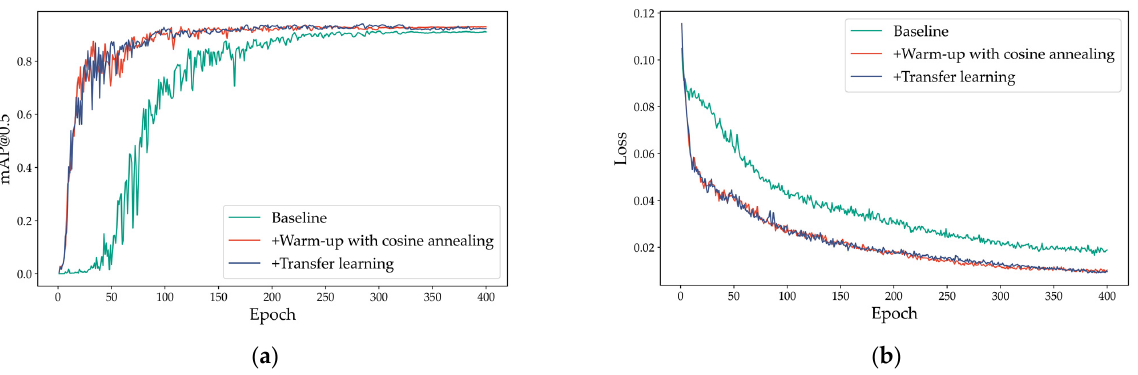
Figure 11. Influence of warm-up with cosine annealing and transfer learning on network. ( a ) mAP@0.5 and ( b )